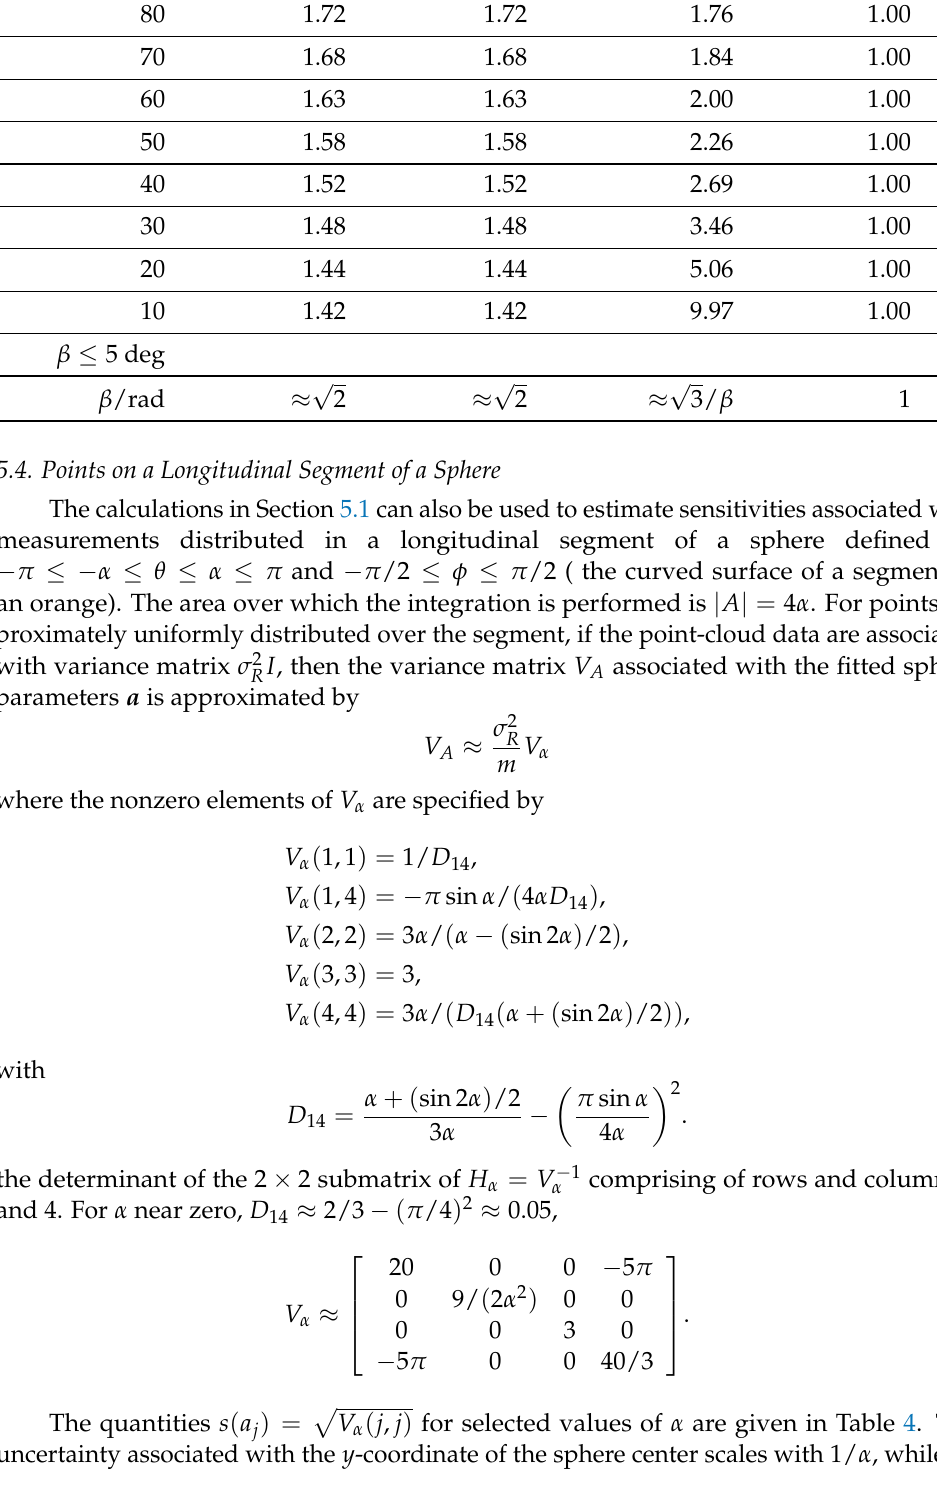
I , the uncertainties R